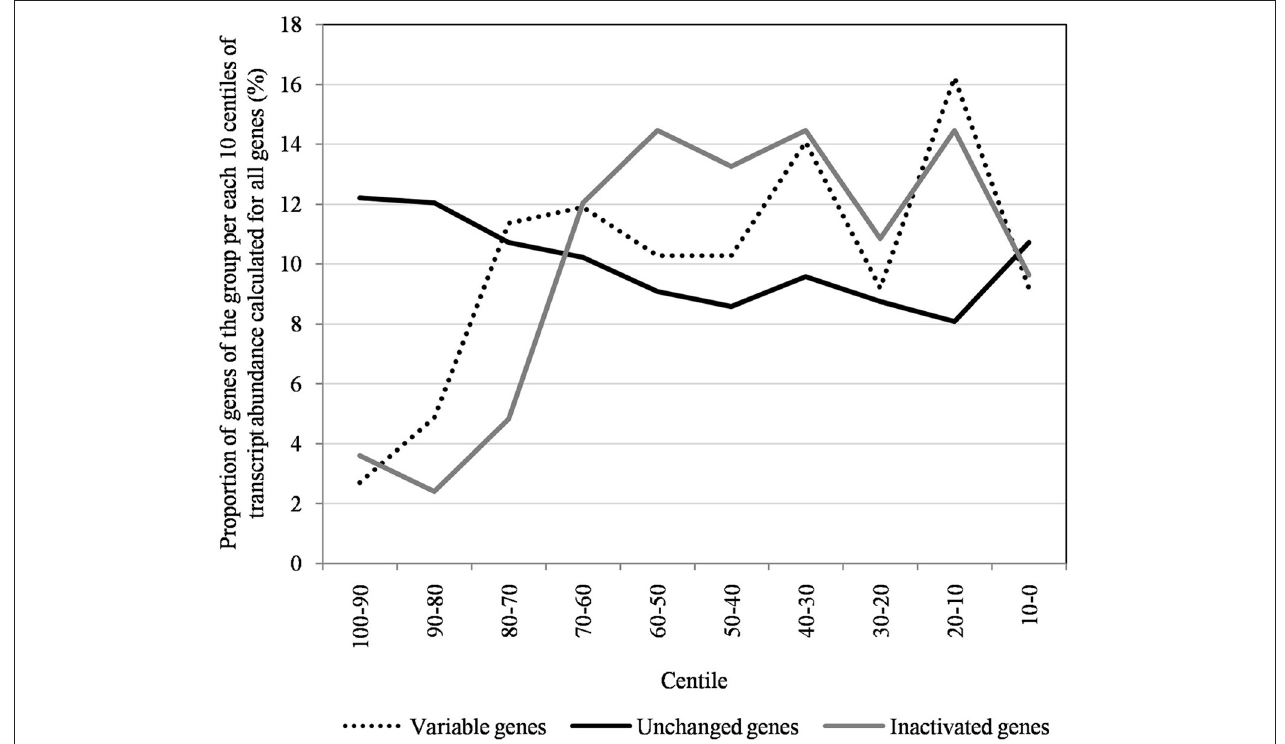
FIGURE 7 | The distribution of unchanged, variable, and inactivated genes after 150 passages in allopatric laboratory culture on amoebae per each 10 centiles of transcript abundance, calculated for all Mimivirus M1